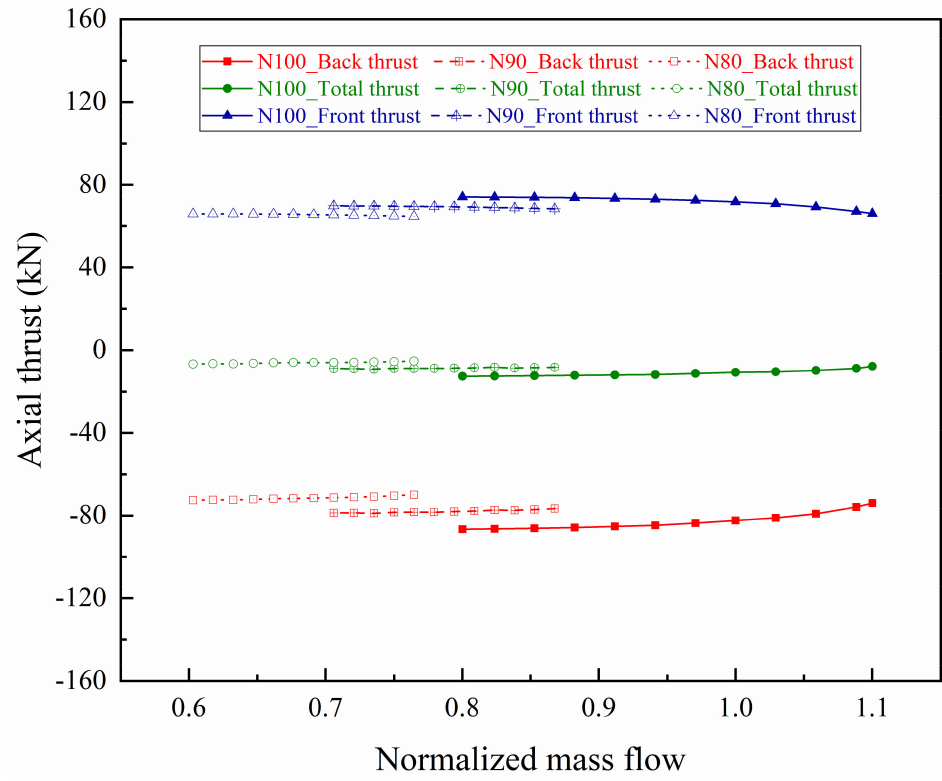
Figure 12. Predicted axial thrust under variable rotating speeds.